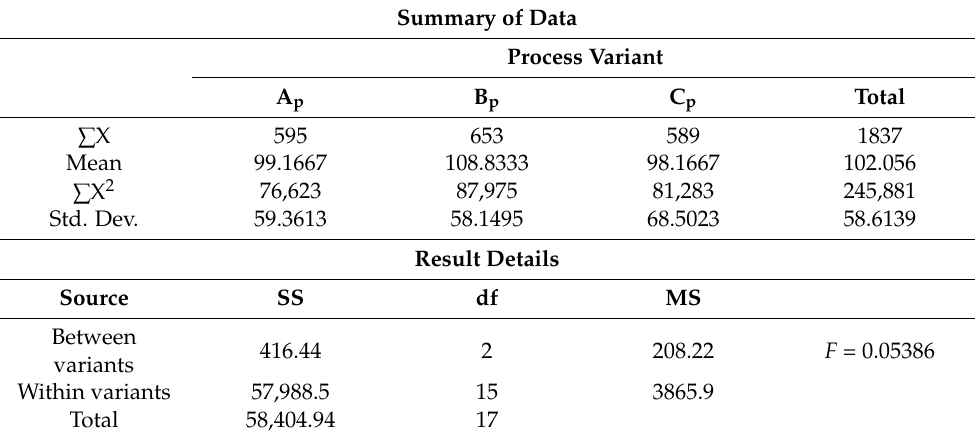
Table 19. Effect of ANOVA analysis of efficiency index of producing semi-finished furniture elements ( p < 0.05).